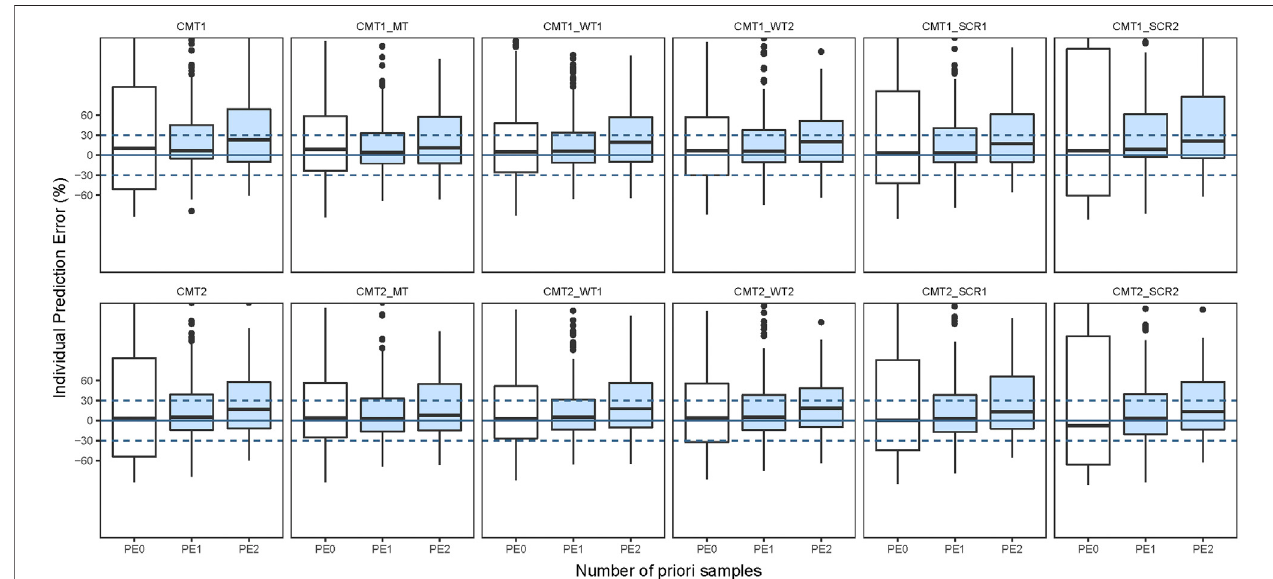
FIGURE3| Boxplotsofindividualprediction error(IPE%) inexternaldatawithBayesianforecasting foronecompartmentalmodel(CMT1) and twocompartmental model (CMT2) and including maturation model (MT), WT on nonlinear model (WT1) and WT on linear model (WT2), SCR on nonlinear model (SCR1) and SCR on linear model(SCR2)inexternalvancomycindata(0representspredictionswithout prior informationandonetotworepresentswith prior